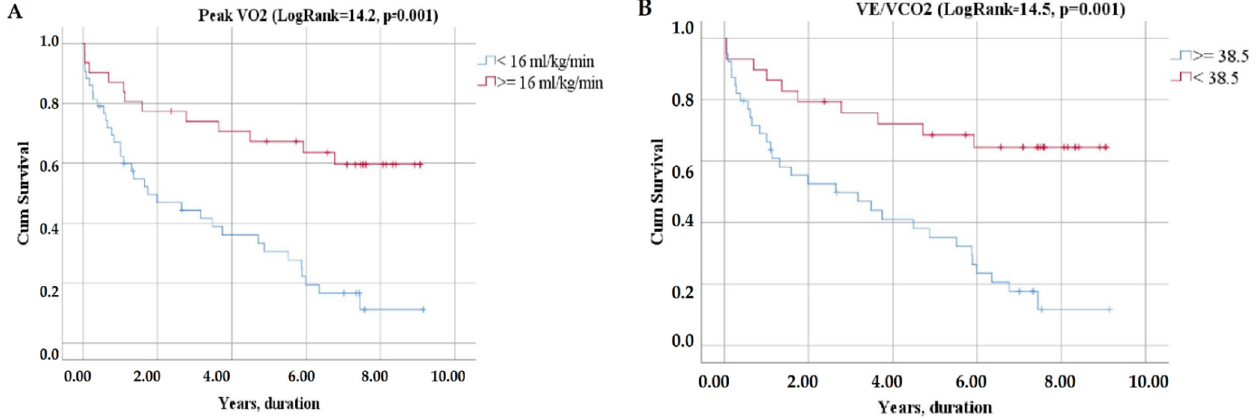
Figure 5. Kaplan–Meier curves of event-free survival according to CPET parameters: V0 2 peak ( A ), VE/VCO 2 ( B ).